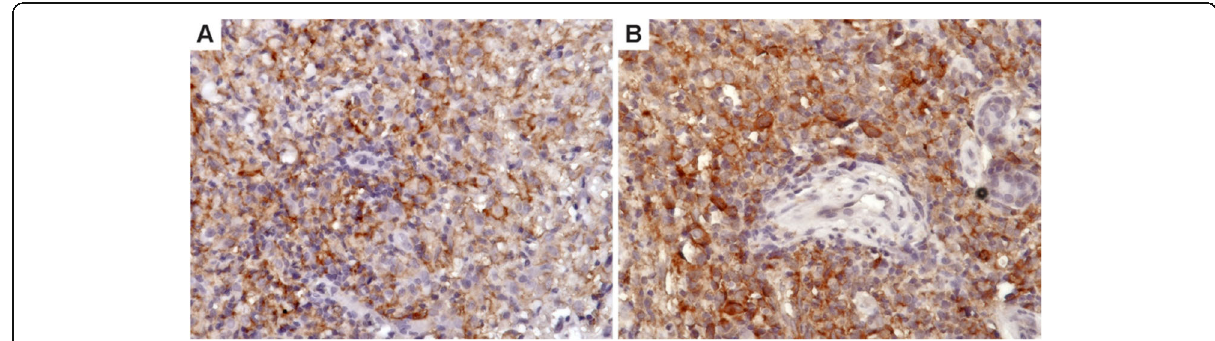
Fig. 3 PD-L1 expression in lymphomatoid papulomatosis ( a – 400X) and primary cutaneous anaplastic large cell lymphoma ( b – 400X), showing expression in both tumor cells and tissue associated macrophages